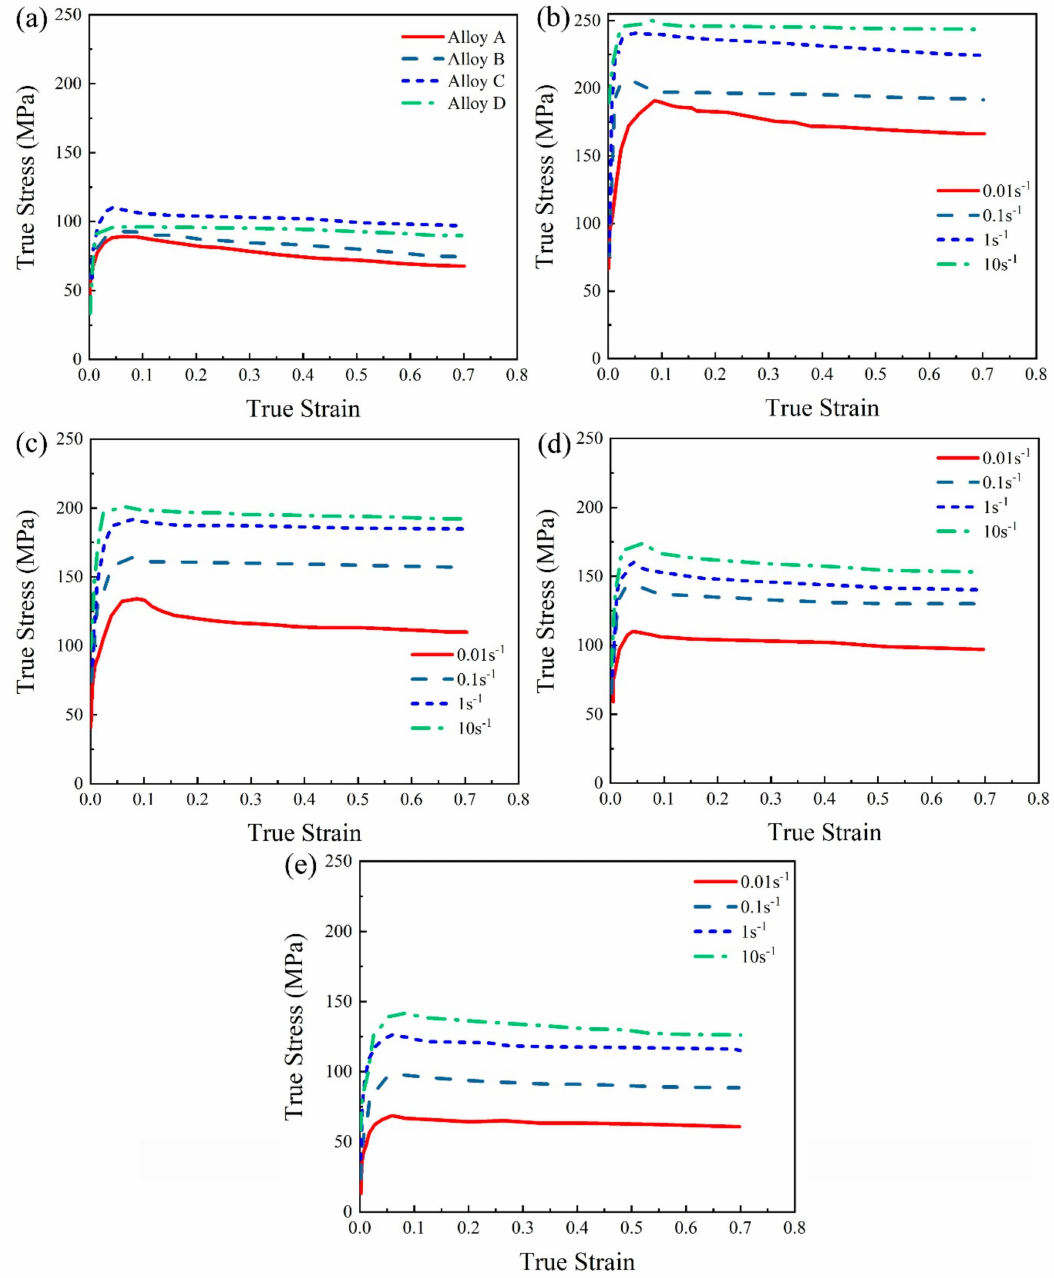
Figure 4. True stress–true strain curves of alloys during hot deformation after homogenization ( a ) alloy 5083 with various V contents compressed at 400 ◦ C and 0.01 s − 1 , ( b – e ) alloy C compressed at di ff erent temperatures and strain rates ( b ) 300 ◦ C, ( c ) 350 ◦ C, ( d ) 400 ◦ C and ( e ) 450 ◦